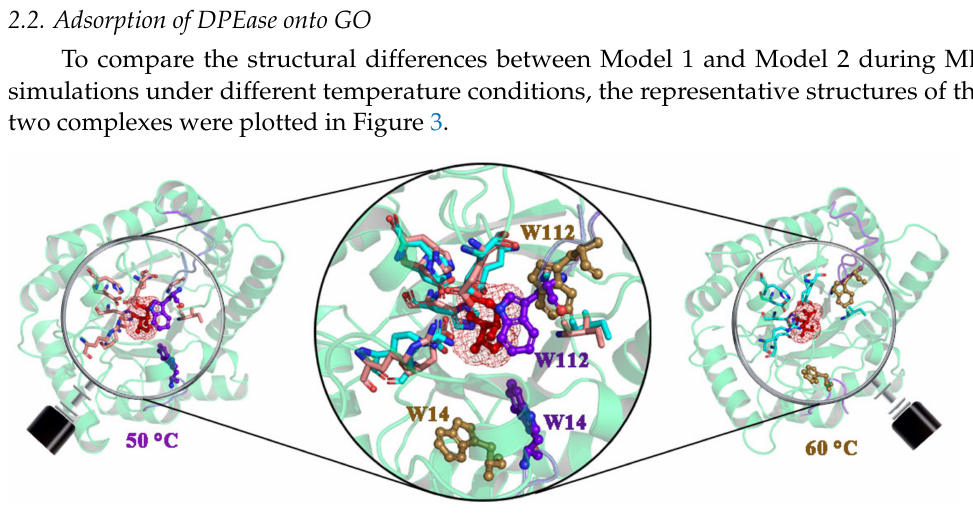
Figure 3. Representative structure for the complex at 50 ◦ C and 60 ◦ C. Additionally, the superimposi- tion of two structures, in which DPEase are displayed in cartoon and active pockets, are represented in different color